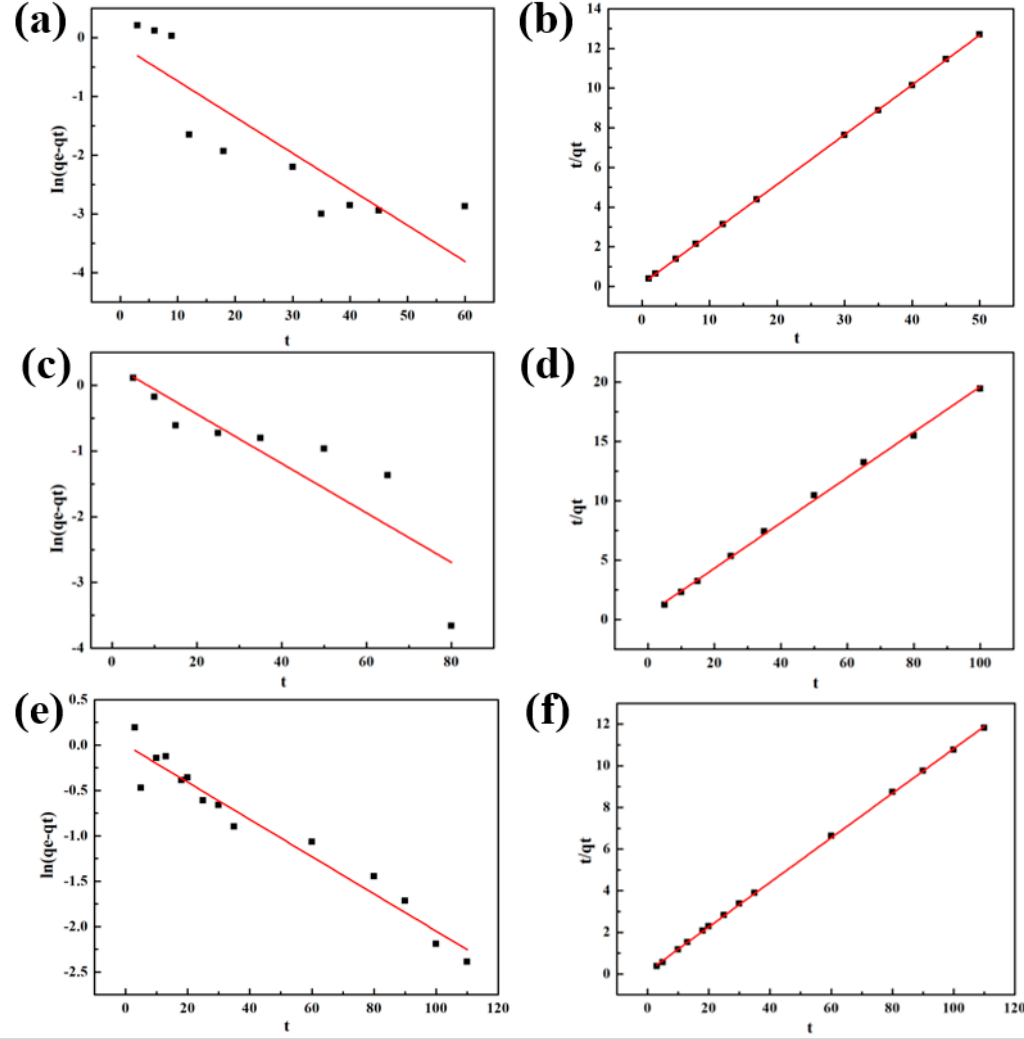
Table 4. Adsorption kinetic parameters.